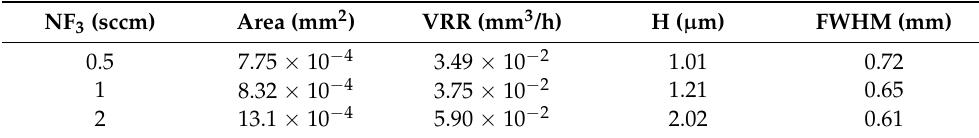
Figure 3. Etch profiles of SiC wafer specimens etched on 6 mm line with He 2 slm and NF 3 0.5, 1, 2 sccm mixed gas filament plasma. (Pset: 100 W, tool moving speed: 1 mm/s, 80 times). Table 2. Etch profile parameters of the specimens in Figure